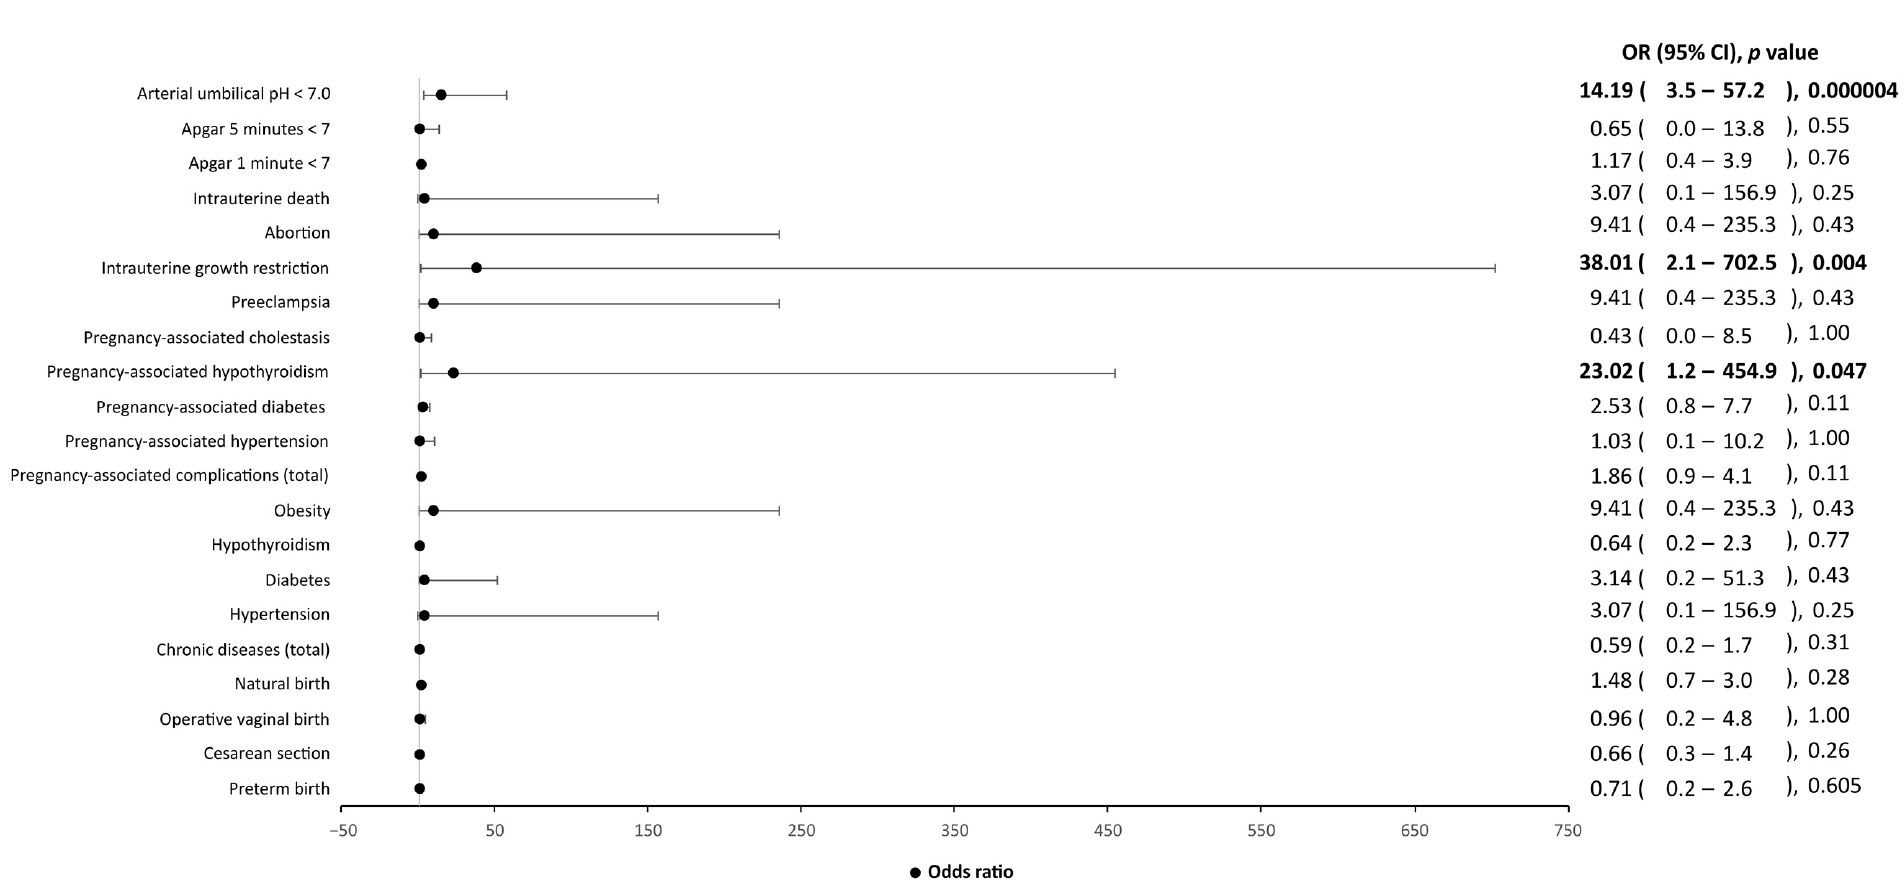
Figure 4. Influence of clinical factors, including chronic diseases, pregnancy-associated complications, and Apgar score, on asymptomatic SARS-CoV-2-positive mothers and their children, as compared to SARS-CoV-2-negative mothers and their children. OR, odds ratio; CI, confidence interval. Values in bold indicate statistical significance, as the level of statistical significance was set to p < 0.05.